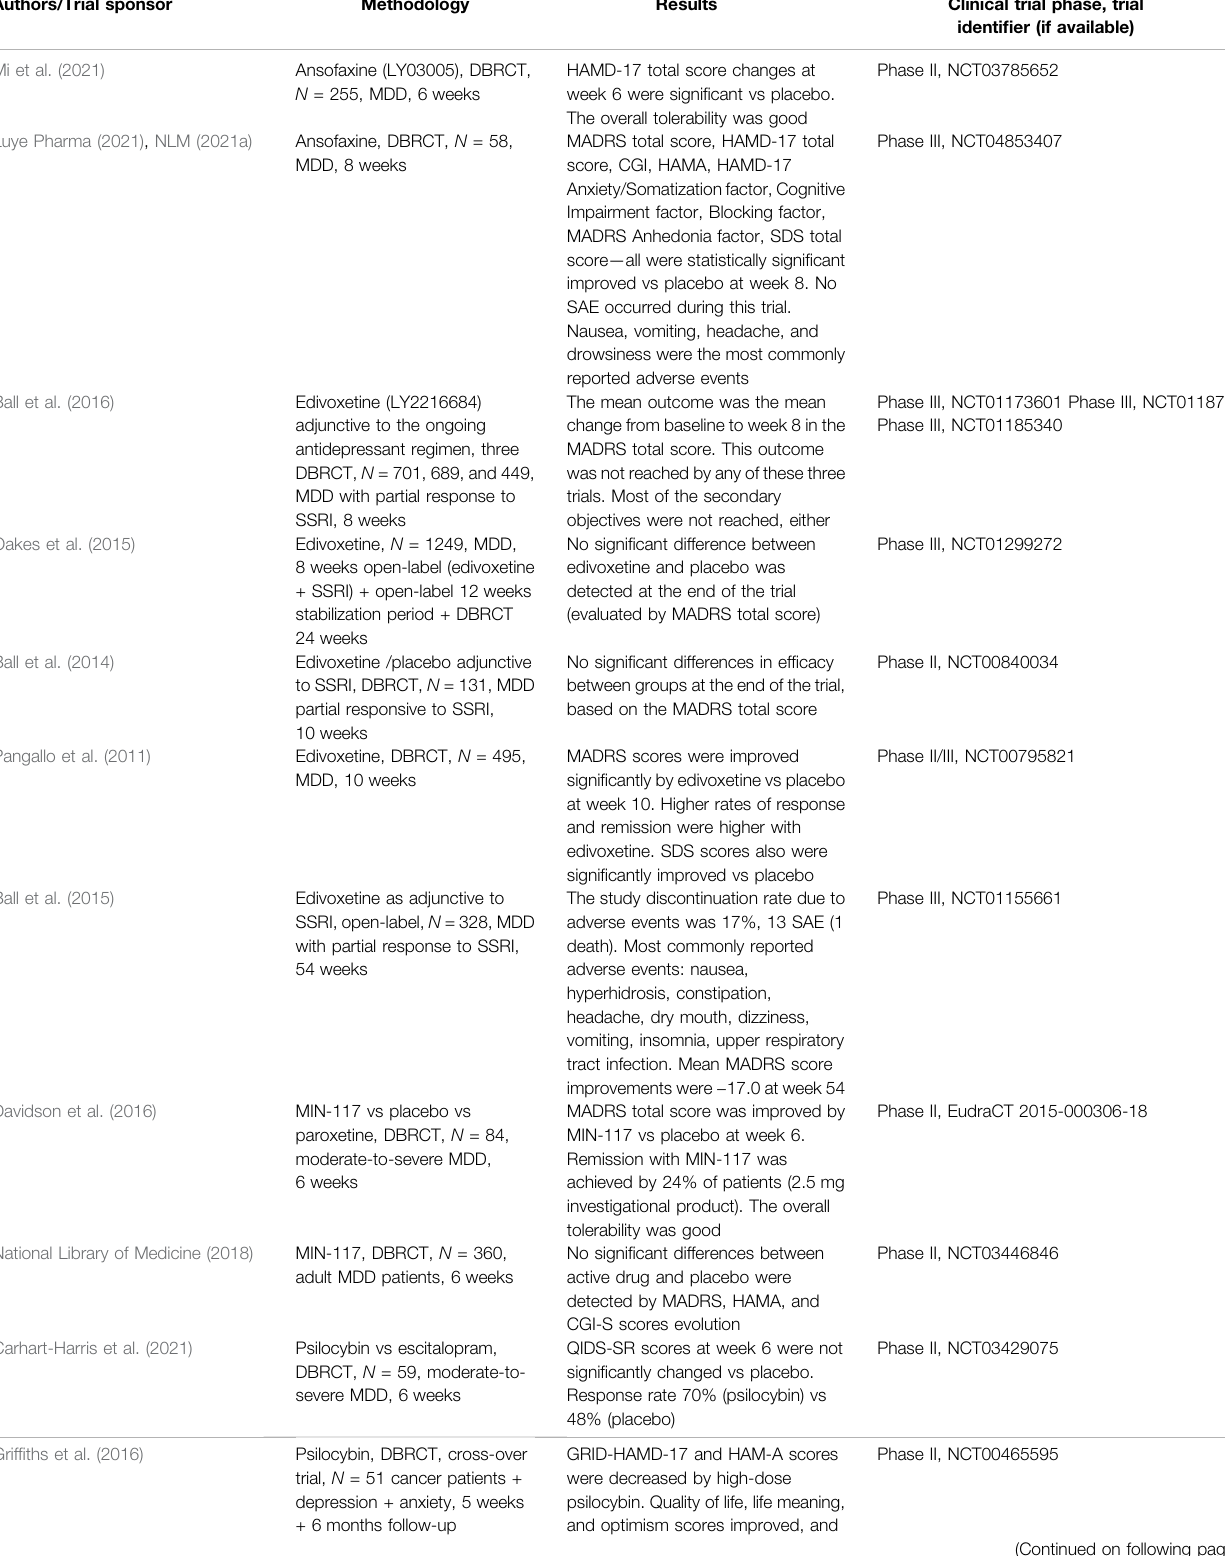
TABLE 3 | Monoaminergic modulators with antidepressant properties in the pipeline. Authors/Trial